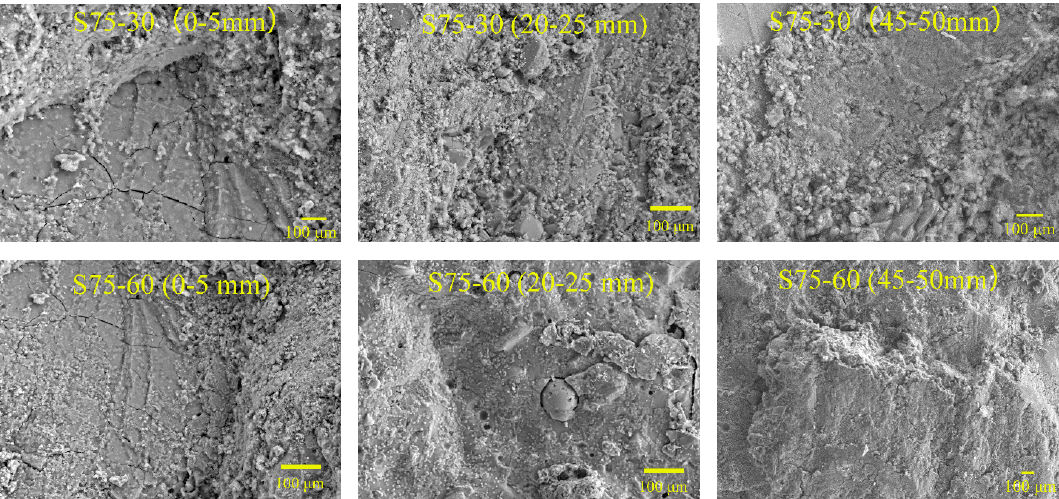
Figure 11. SEM images of S75 concretes, after 0, 15, 30, and 60 cycles of sulfate attack (sample location from attack surface: 0–5 mm, 20–25 mm, and 45–50 mm).